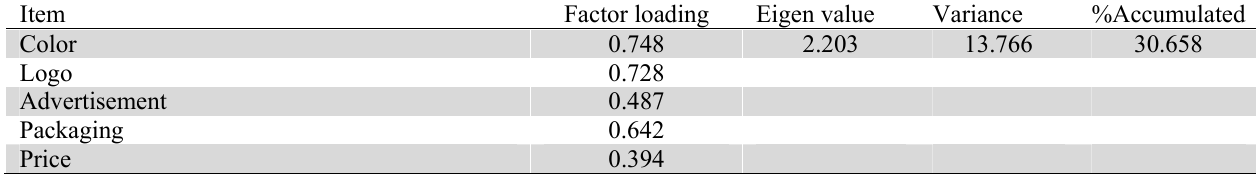
The summary of various components associated with brand characteristics